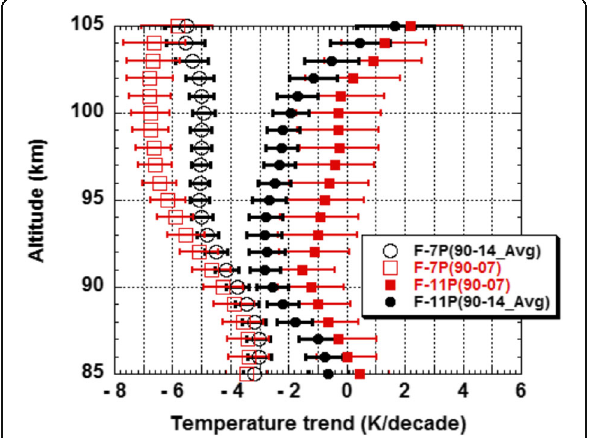
Fig. 16 Linear temperature trend from the quarter century data set with 11- and 7-parameter analyses, respectively, denoted as F- 11P(90-14_Avg) in black solid circles and F-7P(90-14_Avg) in black open circles. Shown for comparison are those data published based on an 18-year data set denoted as F-11P(90-07) in red solid squares and F-7P(90-07) in open red squares (taken from She et al.